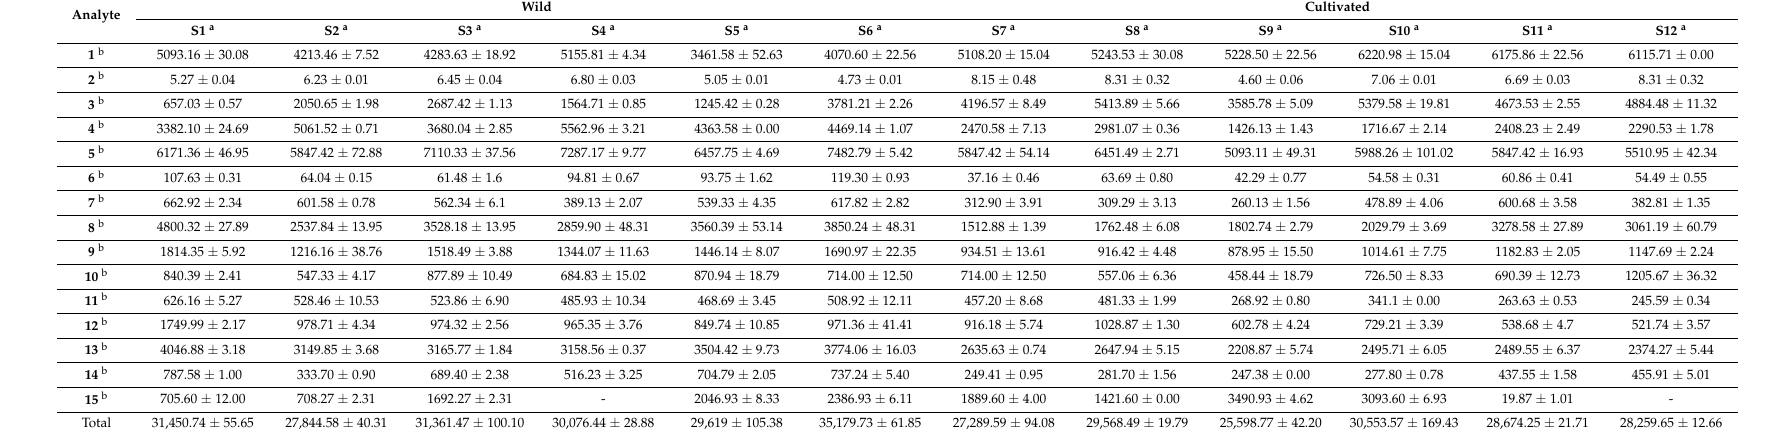
Table 4. Contents of 15 compounds in wuweizi ( µ g/g, mean ± SD, n =